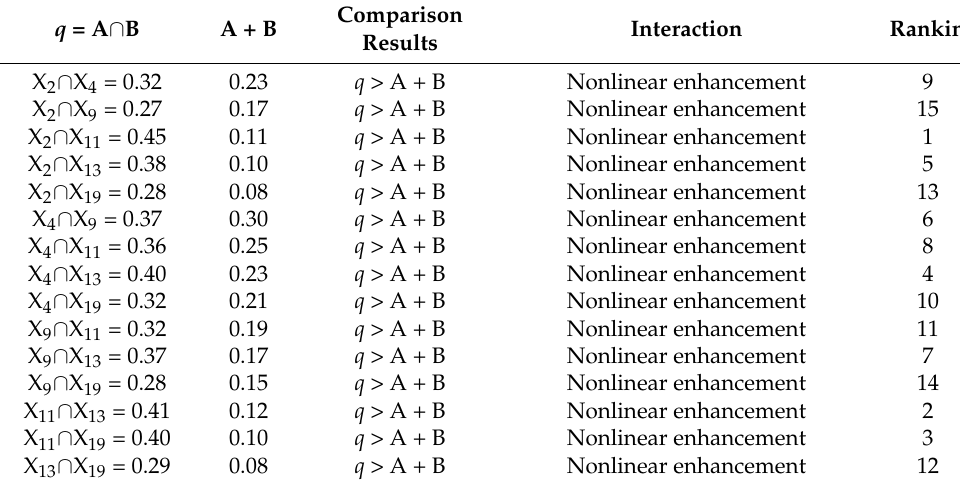
Table 6. Results of dominant factor interaction